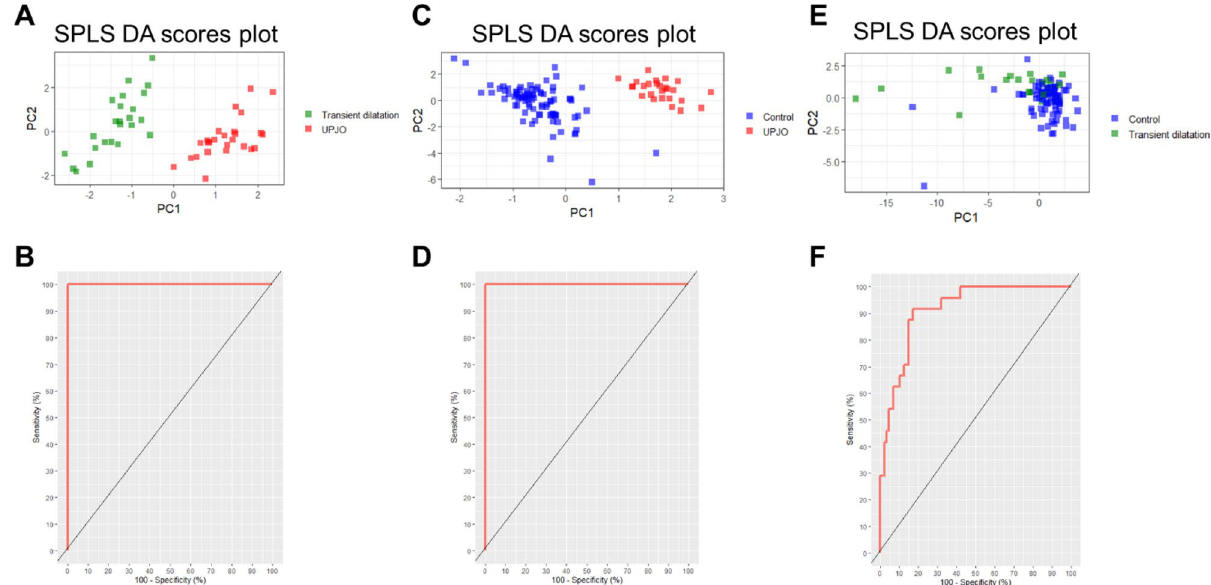
Figure 2. SPLS-DA analysis of UPJO vs TD, UPJO vs controls and TD vs controls. ( A ) SPLS-DA scores plot PC1 (15%) vs PC2 (4%) with a good separation between UPJO (red) vs TD (green) ; ( C ) SPLS-DA scores plot PC1 (14%) vs PC2 (5%) with a good separation between UPJO (red) vs controls (blue); ( E ) SPLS-DA scores plot PC1 (25%) vs PC2 (6%) with a light separation between TD (green vs controls blue). For each model classification, a receiver operating characteristic (ROC) curve is shown ( B , D , F